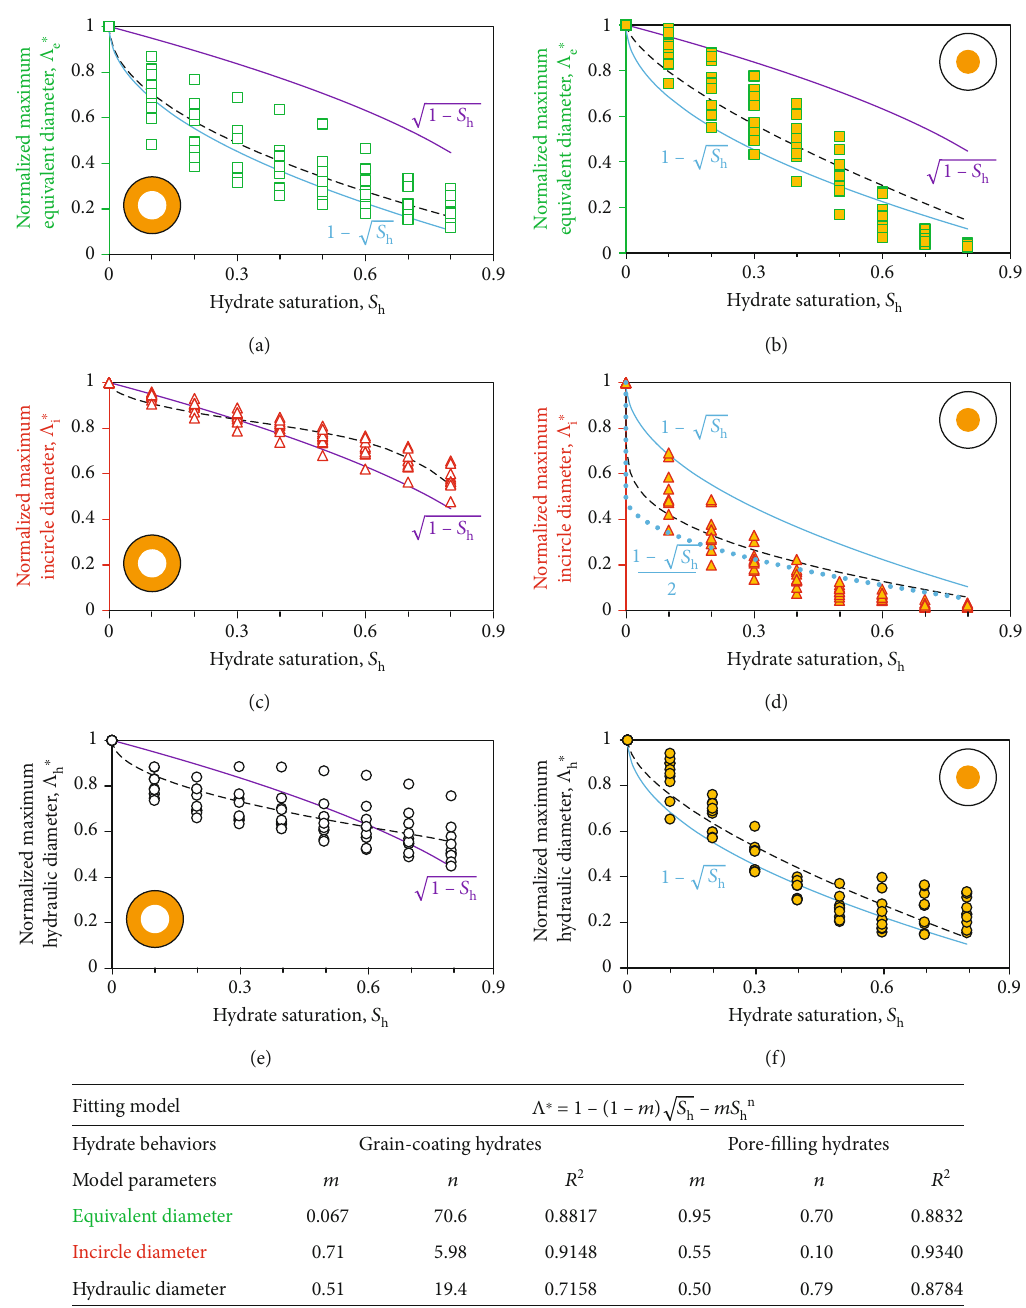
∗ , incircle Λ ∗ , and hydraulic Λ ∗ diameters of fl uid-occupied pores within hydrate-bearing Figure 4: Normalized maximum equivalent Λ e i h porous media evolving with hydrate saturation S h . Normalized maximum equivalent diameter Λ e ∗ for grain-coating (a) and pore- fi lling (b) hydrates. Normalized maximum incircle diameter Λ i ∗ for grain-coating (c) and pore- fi lling (d) hydrates. The blue solid dot curve in (d) is p ffiffiffiffiffi ∗ = 1 when S Þ /2 when S S > 0 and Λ = 0 . Normalized maximum hydraulic diameter Λ drawn by Λ i ∗ = ð 1 − h h i h and pore- fi lling (f) hydrates. (g) A fi tting model and its parameter values for descriptions of di ff erent pore diameters changing with hydrate saturation. The fi tting model is drawn as black dashed curves in (a –